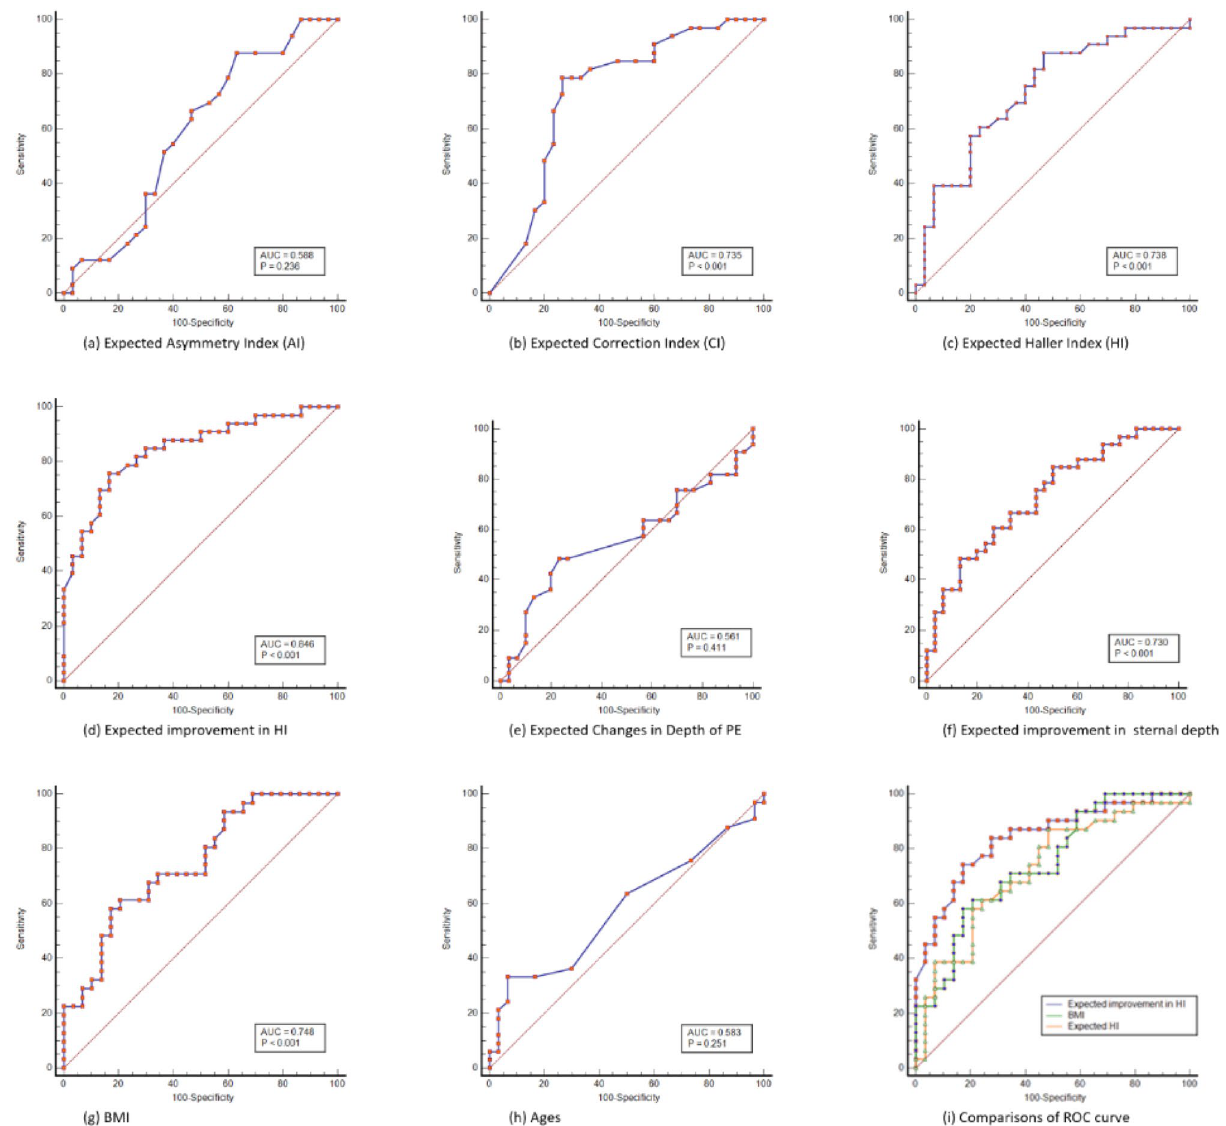
Figure 4. ROC curves of pretreatment variables. ( a )Expected Asymmetric index. The cut-off value was 0.92 with 87.8% sensitivity and 36.7% specificity, which showed no statistical significance ( p = 0.236). ( b ) Expected Correction index. The cut-off value was 0.07, with 78.8% sensitivity and 73.3% specificity ( p < 0.001). ( c ) Expected Haller index. The cut-off value was 3.1, with 87.9% sensitivity and 53.3% specificity ( p < 0.001). ( d ) Expected improvement in Haller index. The cut-off value was 0.46, with 75.8% sensitivity and 83.3% specificity ( p = 0.001) ( e ) Expected improvement in depth of PE. The cut-off value was 0.4 cm, with 48.5% sensitivity and 76.7% specificity which showed no statistical significance ( p = 0.411). ( f ) Expected improvement in sternal depth (calculated from chest CT). The cut-off value was 0.8 cm, with 48.5% sensitivity and 86.7% ( p < 0.001). ( g ) BMI. The cut-off value was 18.5, with 58.0% sensitivity and 82.8% ( p < 0.001). ( h ) Age. The cut-off value was 16, with 33.0% sensitivity and 93.3%, which showed no statistical significance ( p = 0.251). ( i ) comparison with ROC curves of variables which showed higher classification performance. The Expected improvement in HI revealed better capability than other chest CT with or without VB devices) > 0.46, which showed most favorable discriminatory ability for successful treatment among other variables (AUC = 0.846 with p = 0.001, cut-off value of 0.46 with sensitivity of 75.7%, and specificity of 83.3%) in ROC curve analysis (Fig. 4). This observation appears to be associated with chest wall flexibility, which has been reported to be related to successful treatment of PE, either surgically or non-surgically 13 . Patients with more flexible chest wall can be expected to achieve better treatment outcomes. Based on this factor, clinicians would be able to tell their patients how their chest deformities will change after 1 year of vacuum bell therapy. The expected CI or HI calculated using chest CT taken after applying a vacuum bell device and the expected improvement in sternal depth could be supplementary tools in predicting outcomes.